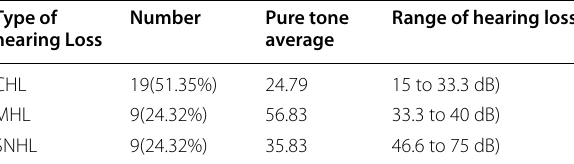
Table 1 The type of hearing loss with Pure tone average and range of hearing loss